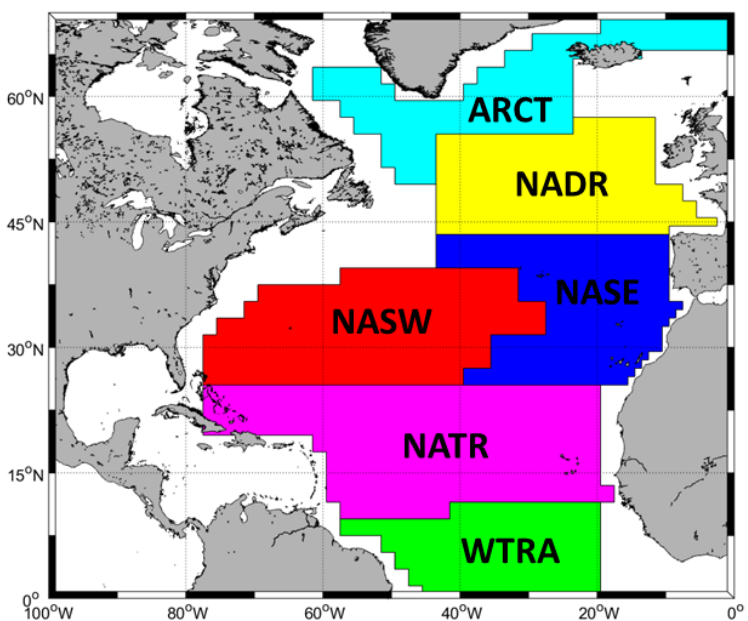
Figure 2. Location of the North Atlantic sub-ecological regions as defined by Longhurst (1998) [19]. Region acronyms are defined explicitly in the text. Table 2. Computing surface pressure from chl-a in the North Atlantic ecological regions assuming a threshold surface pressure ( π thresh ) of 3 mNm − 1